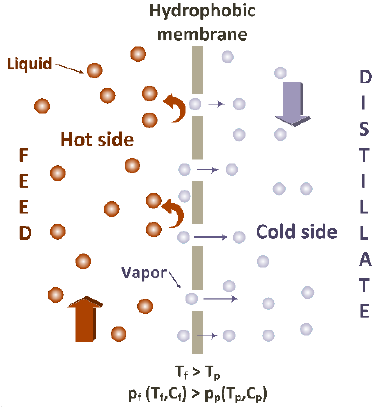
Figure 1. Membrane distillation (MD) principle.